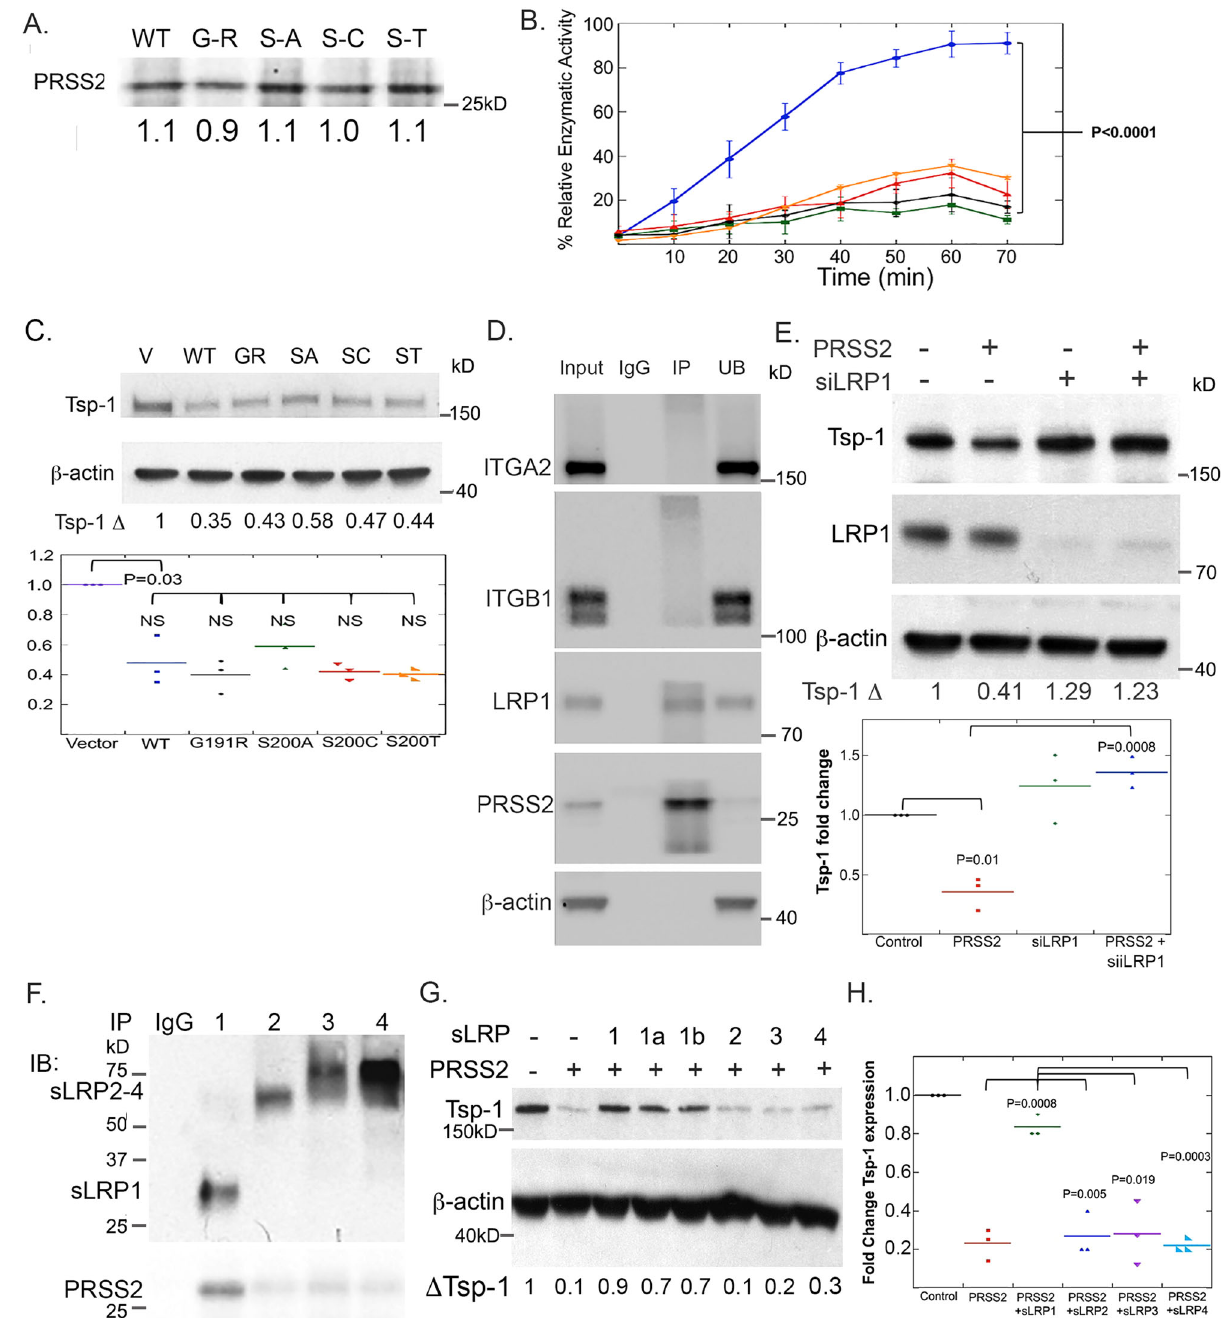
Fig. 2 | PRSS2 represses Tsp-1 via enzyme-independent binding to LRP1. A Western blot of PRSS2 protein levels in conditioned media of 293T cells transfected with WT PRSS2 (blue), PRSS2-G191R (black), PRSS2-S200A (green), PRSS2-S200C (red), and PRSS2-S200T (orange) ( n =3). B Plot of enzymatic activity WT and mutant PRSS2 proteins relative to WT PRSS2 (%) ( n =3) ( P value calculated viatwo-sidedStudent ’ s t test; error barsdepict SEM).Westernblotsof: C Tsp-1 and actin expression in WI38 fi broblasts treated with CM from 293T cells transfectedwithemptypCMV-Sport6vectoror(pCMV-Sport6-PRSS2oramutant version of PRSS2 (GR=G191R, SA=S200A, SC=S200C, ST=S200T) ( n =3; P value calculated via two-sided Student ’ s t test). D Integrin α 2 (ITGA2), Integrin β 1 (ITGB1), LRP1, PRSS2, and actin following immunoprecipitation with control IgG, or α -PRSS2 (IP) antibody and unbound protein (UB) in WI38 cells ( n =3). E